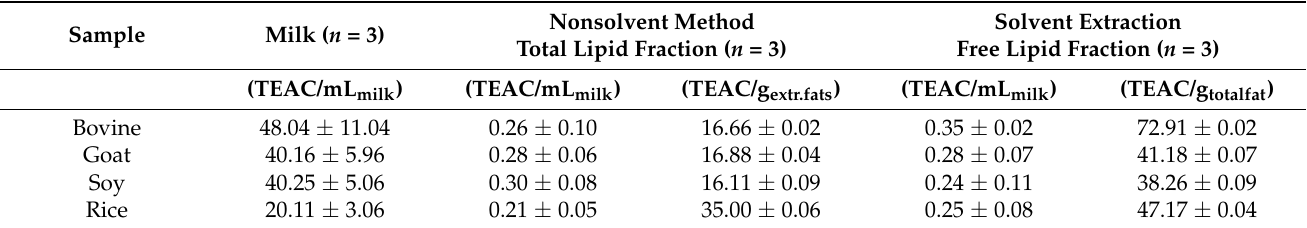
Figure 3. GC-MS area counts of FFAs in the solvent-extracted TMS derivates from the commercial animal and vegetable tested milks. Amount of ( a ) medium-chain FAs (capric and lauric acid, respectively), ( b ) SFAs (myristic, palmitic, and stearic acid, respectively), ( c ) UFAs (palmitoleic, oleic, and linoleic acid, respectively), ( d ) odd-chain fatty acids (OCFAs) (pentadecanoic and margaric acid, respectively) in bovine, goat, soy, and rice milks. Table 2. Average TEAC values obtained by the raw milks and by the corresponding total and free lipid fractions obtained with the nonsolvent method ( n = 3) and with solvent extraction ( n = 3),